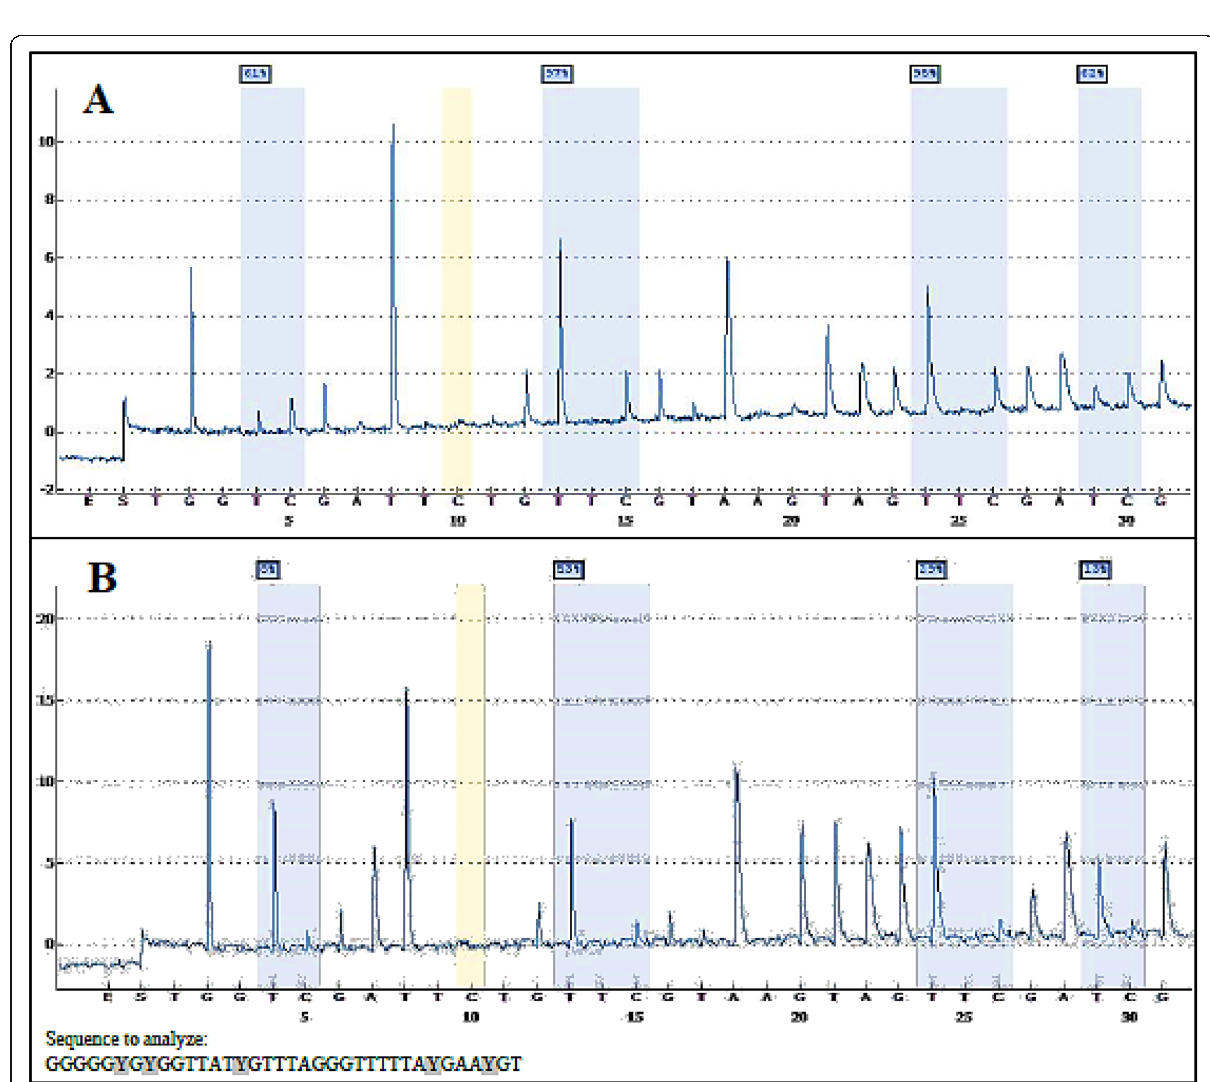
Fig. 1 An example of a pyrogram produced by pyrosequencing of the SCGB3A1 gene promoter. A Tumor group. B Normal group. The gray highlights mark the tested CpG sites and the percentage methylation readings. X-axis, dispensation order; Y-axis, relative light